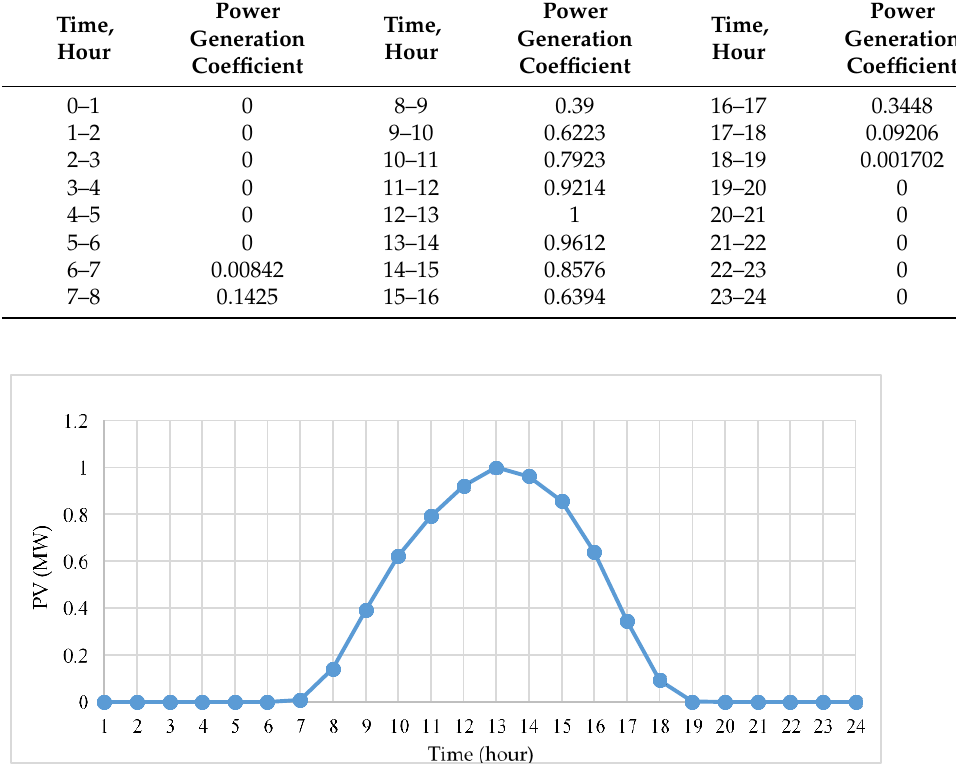
Figure 13. Daily solar power generation curve.